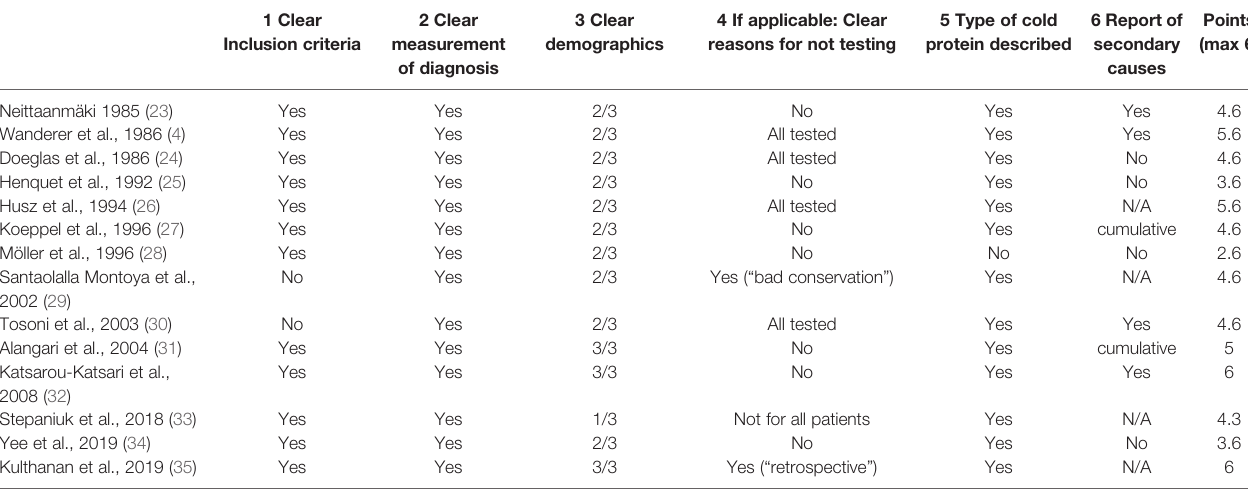
TABLE 1 | Quality assessment of the studies identi fi ed through the systematic literature